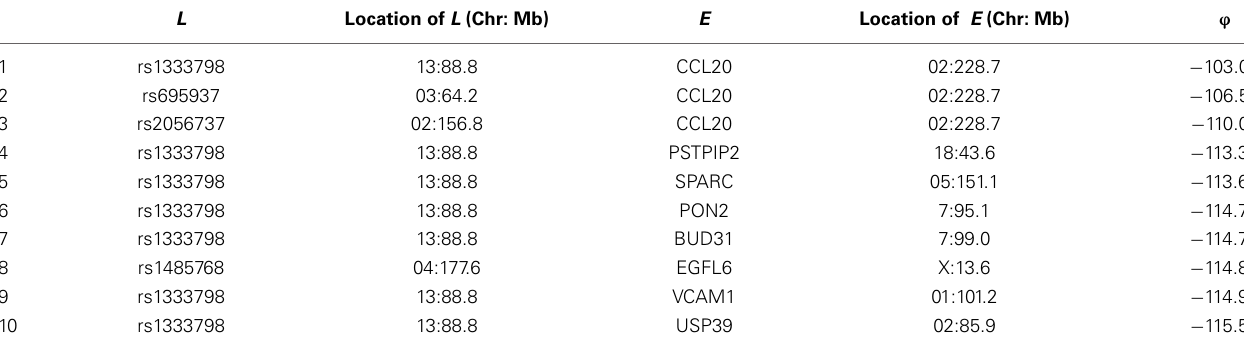
Table 1 | Top 10 scoring triplets for docetaxel, and associated ϕ scores.